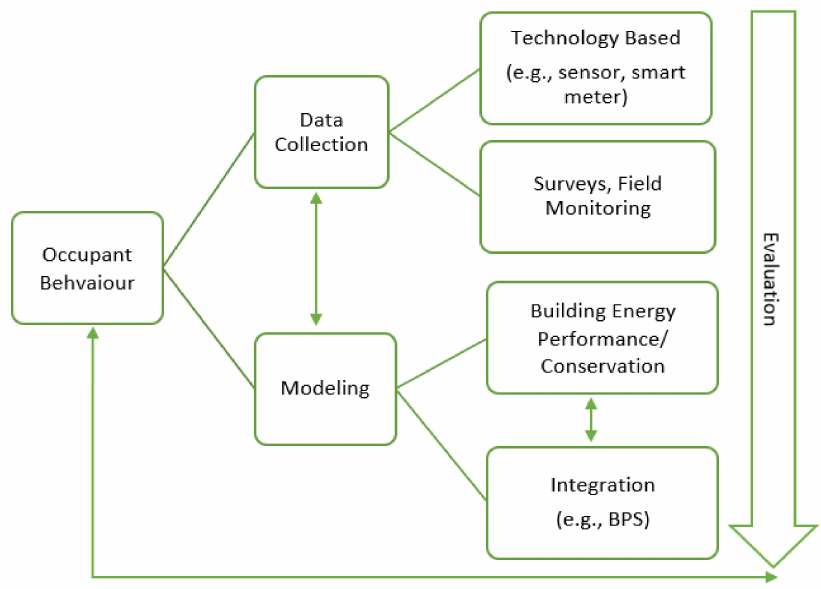
Figure 8. The structural framework of behavior modeling and